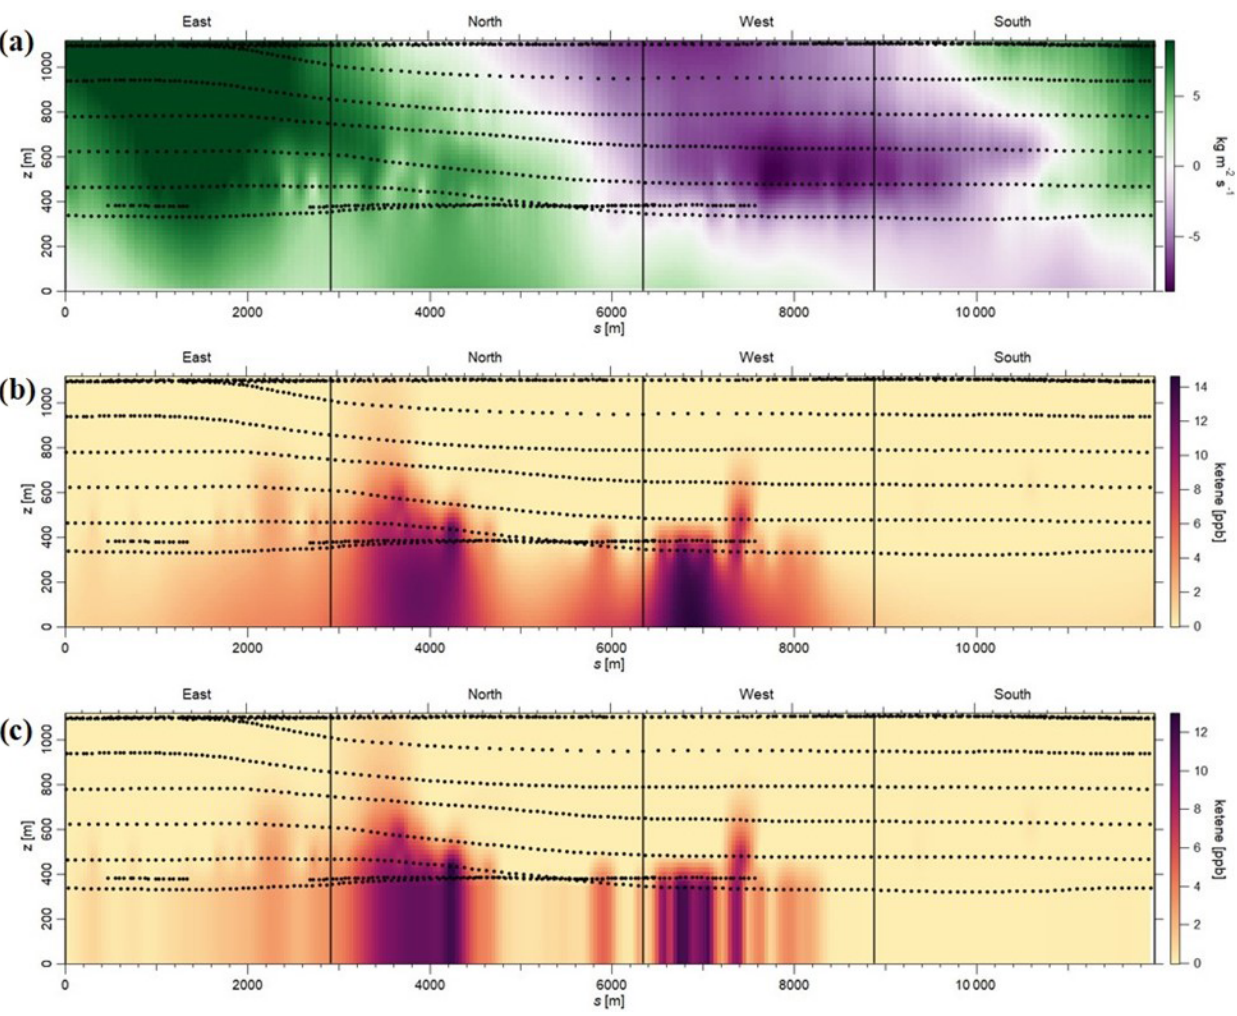
Figure 4. Estimation of uncertainty in the emission rates, using the first approach, during 29 May morning flight. (a) Air flux screen (green – going out of the facility; purple – going into the facility). (b) Case 1: linear extrapolation, using radial basis function (net emission rate from the facility – 312.36kgh − 1 ; emission rate going out of the screen – 357.73kgh − 1 ). (c) Case 2: linear extrapolation using the constant case (net emission rate from the facility – 262.44kgh − 1 ; emission rate going out of the screen –298.74kgh − 1 ; exponentials are the same for both the cases; uncertainty is ∼